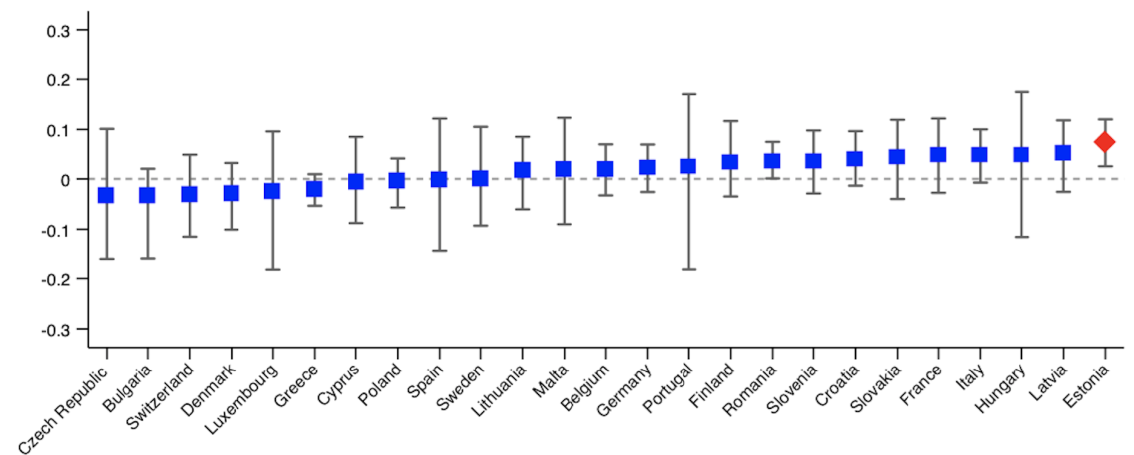
Figure 2. Horizontal inequity indices in postponed health care during the COVID-19 pandemic across European countries. Note: red diamond indicates p < 0.05. Bootstrapped bias corrected 95% confidence intervals.